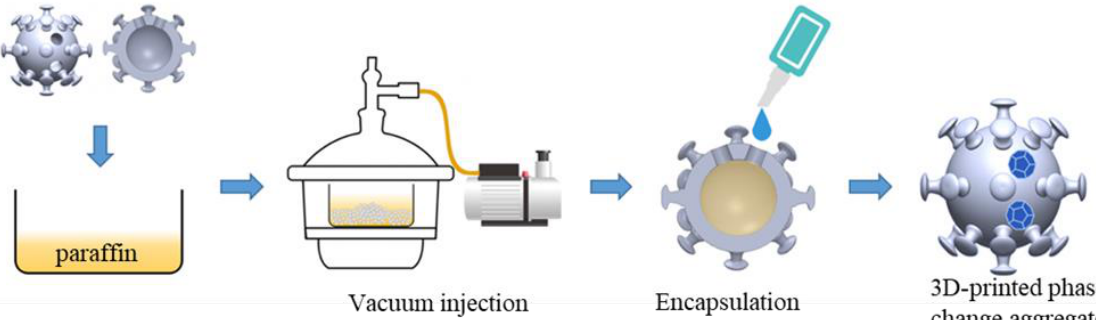
Figure 3. Encapsulation process of phase change aggregate. (The 3D-printed aggregates are vacuum impregnated in molten paraffin wax and then encapsulated with epoxy resin in the small holes reserved for the surface.).